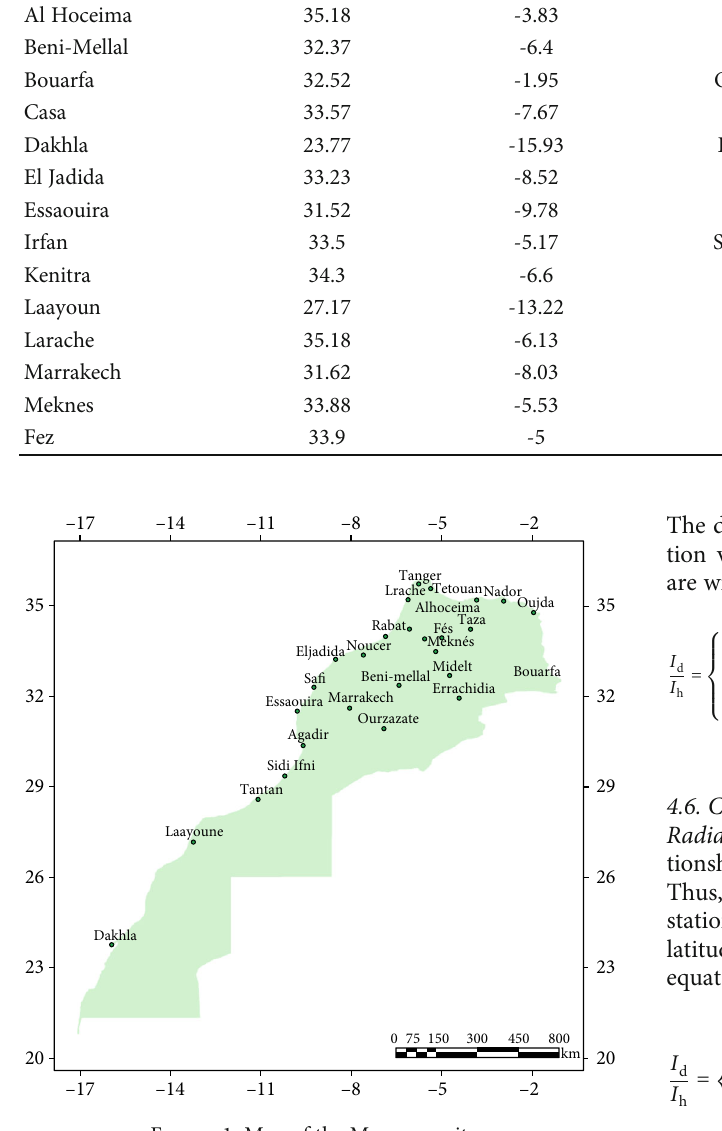
Figure 1: Map of the Moroccan